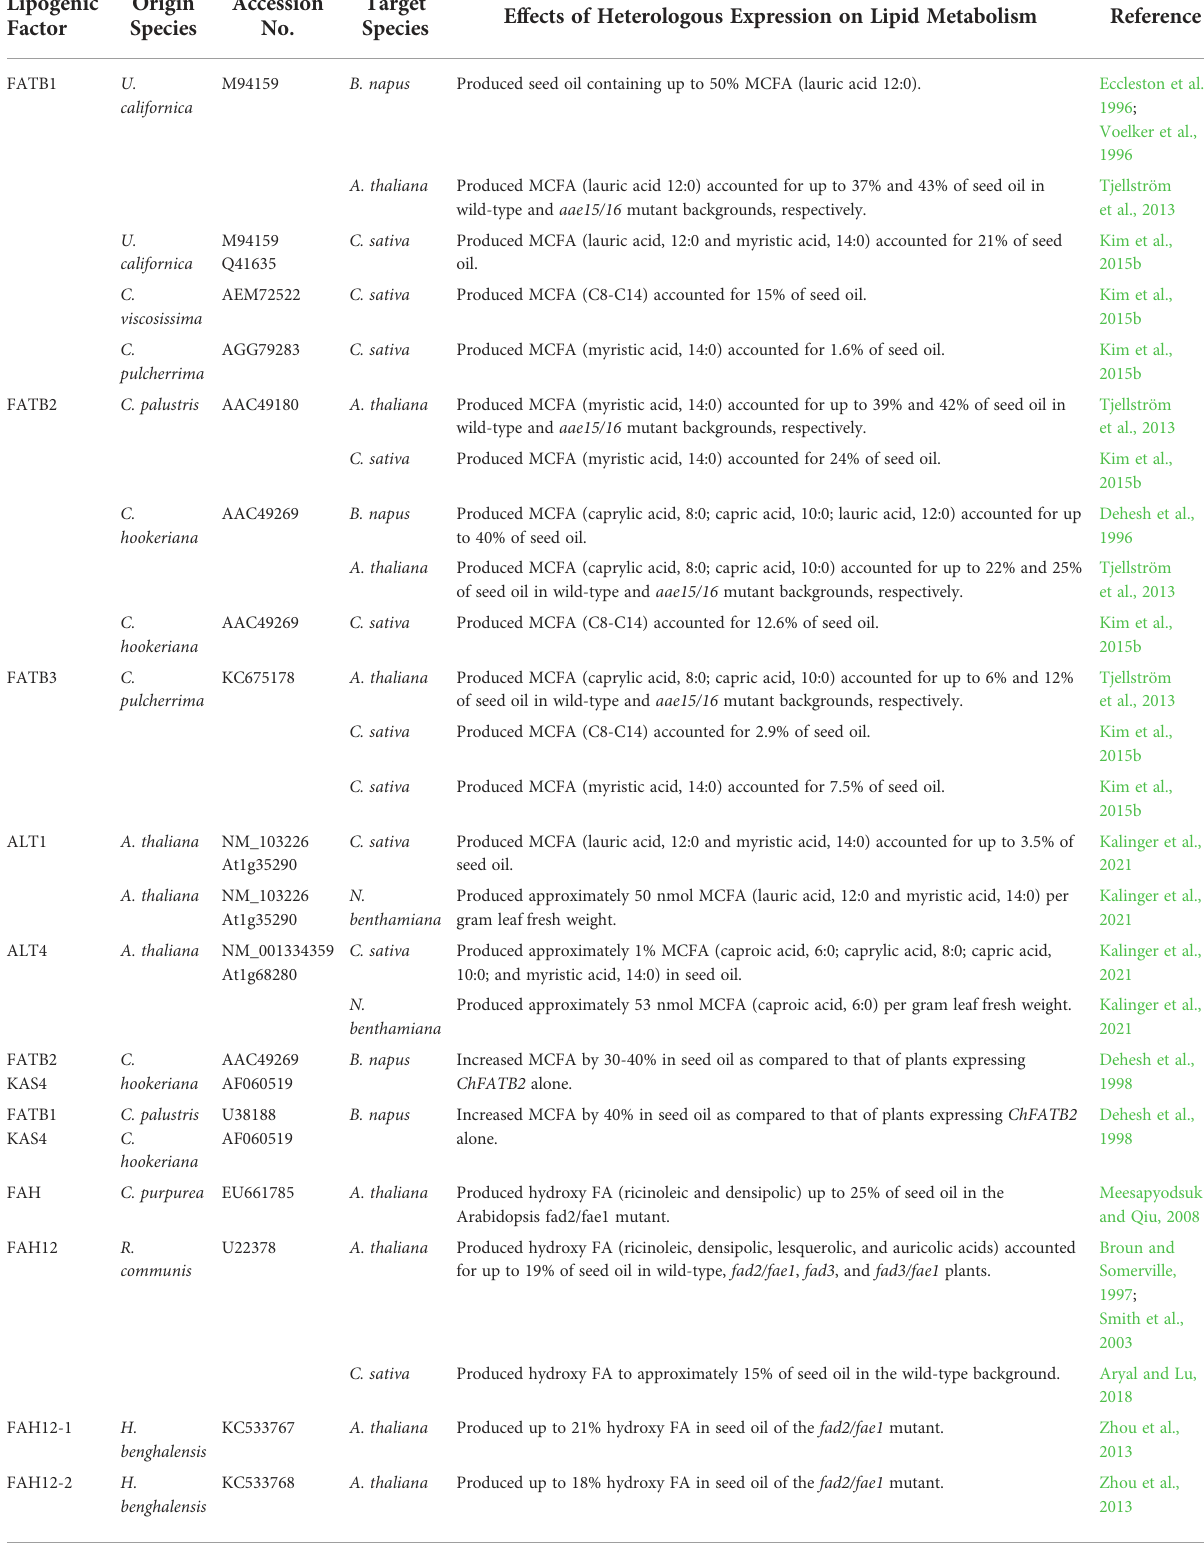
TABLE 1 List of specialized lipogenic factors involved in FA synthesis and modi fi cation used for lipid engineering in plants. Lipogenic